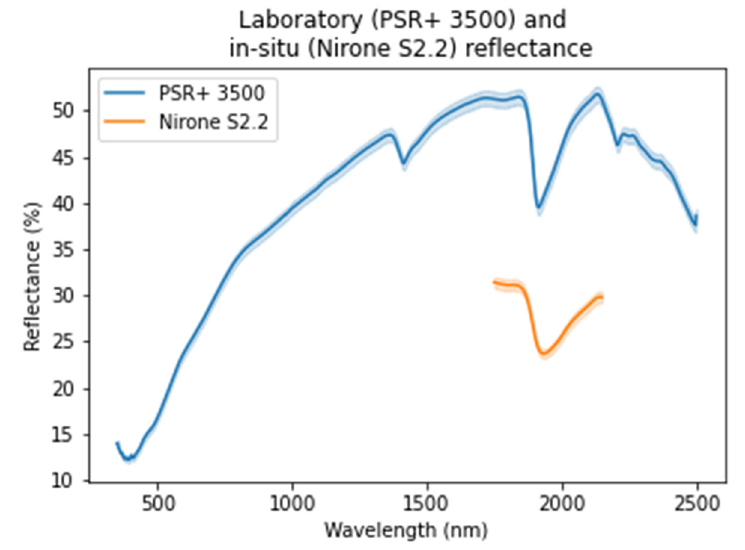
Figure 8. The reflectance of the Vis-NIR laboratory analysis, and the SWIR in situ analysis after the standardization with the ISS was applied (average reflectance and 95% confidence interval).